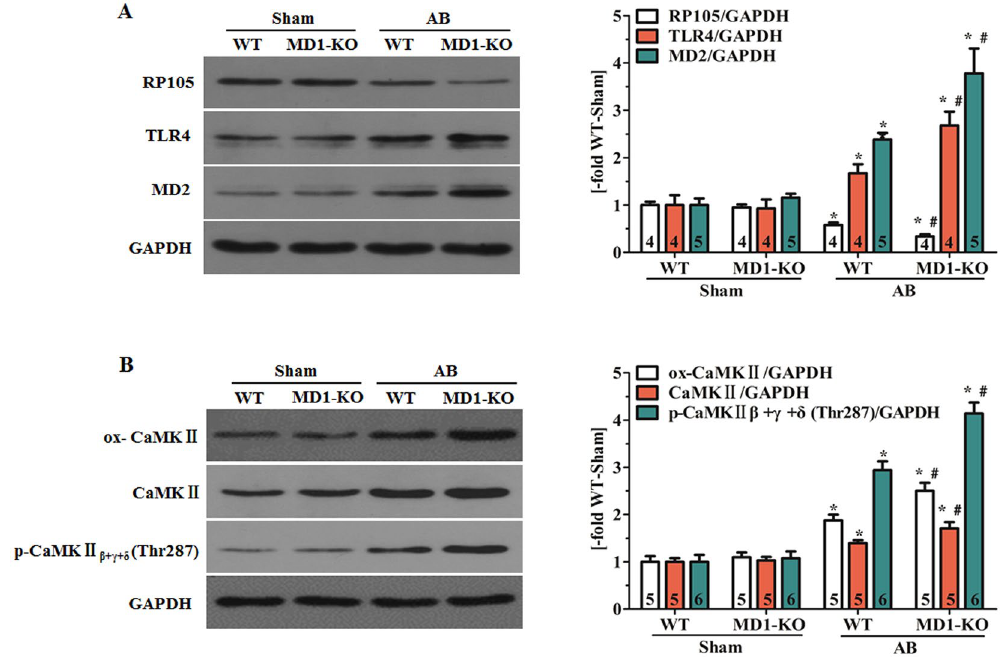
Figure 4. MD1 regulates TLR4 signalling and CaMKII signalling in response to pressure overload. Western blot analysis of WT and MD1-KO left-ventricle samples at 4 weeks after surgery for ( A ) RP105, MD2, and TLR4 expression; ( B ) ox-CaMKII and total CaMKII expression, and phosphorylation of CaMKII β + γ + δ at Thr287. Left: representative immunoblots; right: quantitative results. Data were normalised to GAPDH. Numbers of mice per group are shown inside bars. * P < 0.05 vs. WT-Sham, # P < 0.05 vs.